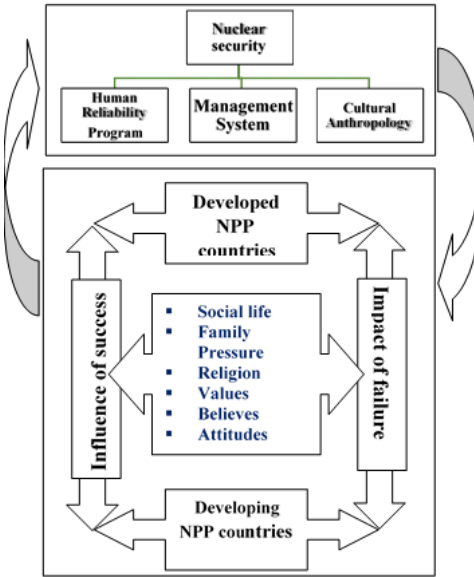
Figure 2. NSC and HRP analysis